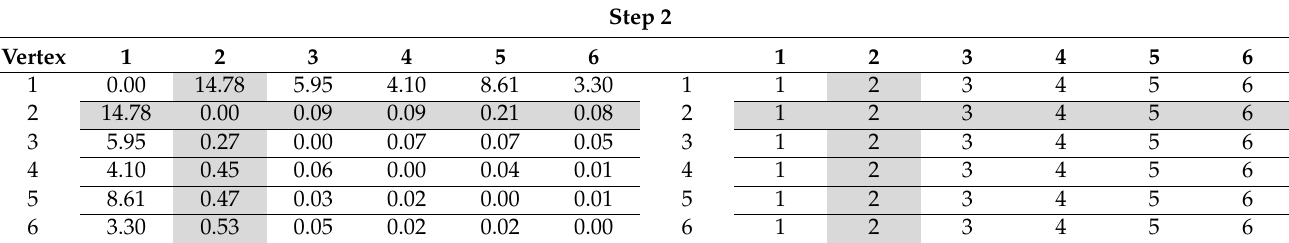
Table A11. The step 2 graphical process of the best search and rescue route.